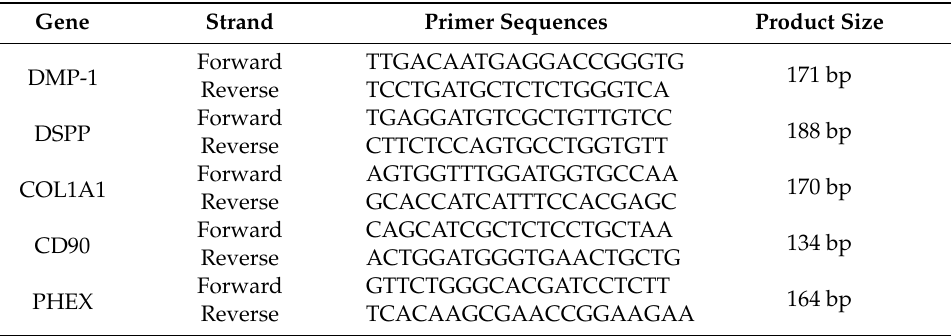
Table 1. The primers used for quantitative